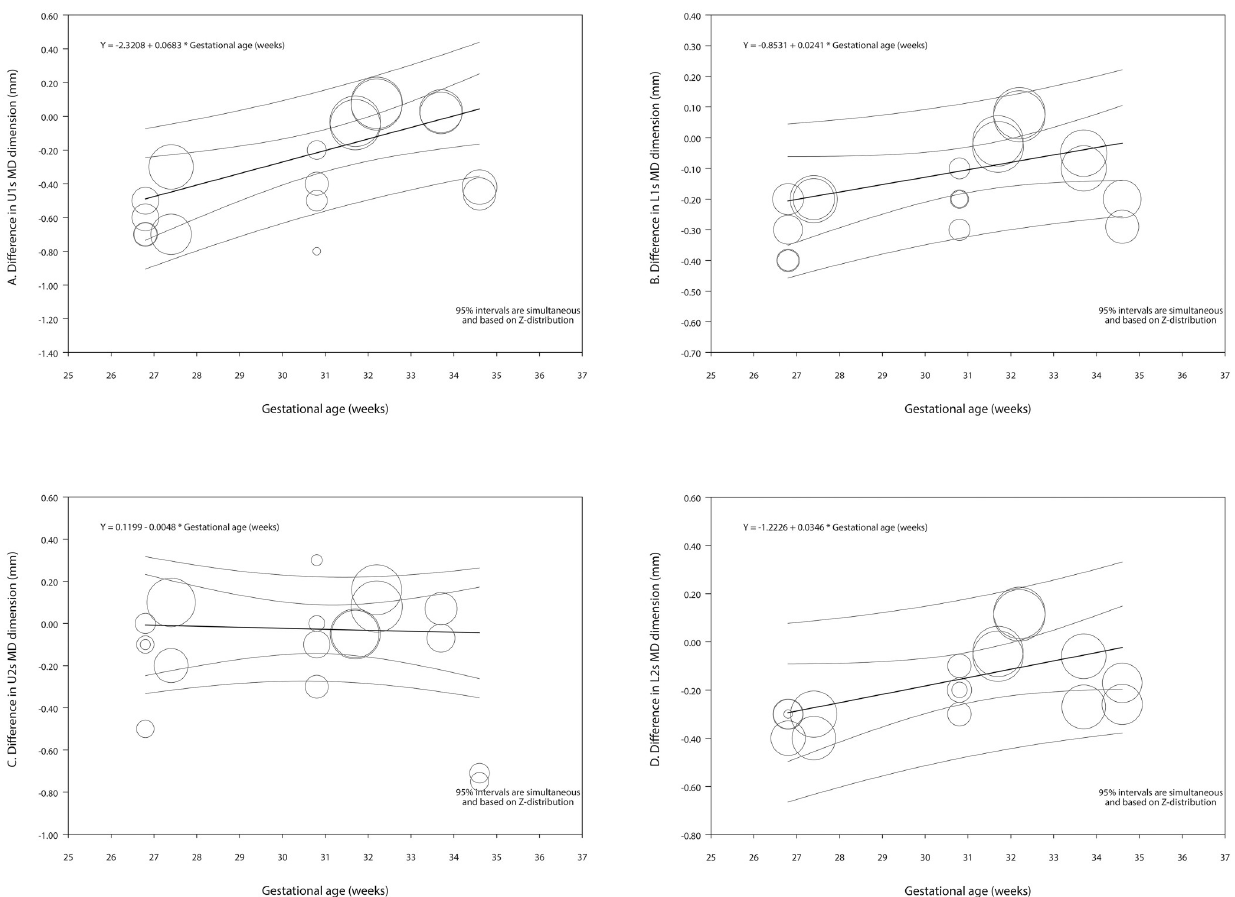
Fig 5. Regression scatterplots of the difference in teeth dimension between preterm and control children, on the predictor of gestational age (in weeks). A. Maxillary central incisor—Mesiodistal dimension. B. Mandibular central incisor—Mesiodistal dimension. C. Maxillary lateral incisor— Mesiodistal dimension. D. Mandibular lateral incisor—Mesiodistal dimension. Confidence intervals and prediction intervals are displayed (inner and outer lines around the regression line). MD: Mesiodistal; L: Lower dental arch; U: Upper dental arch.